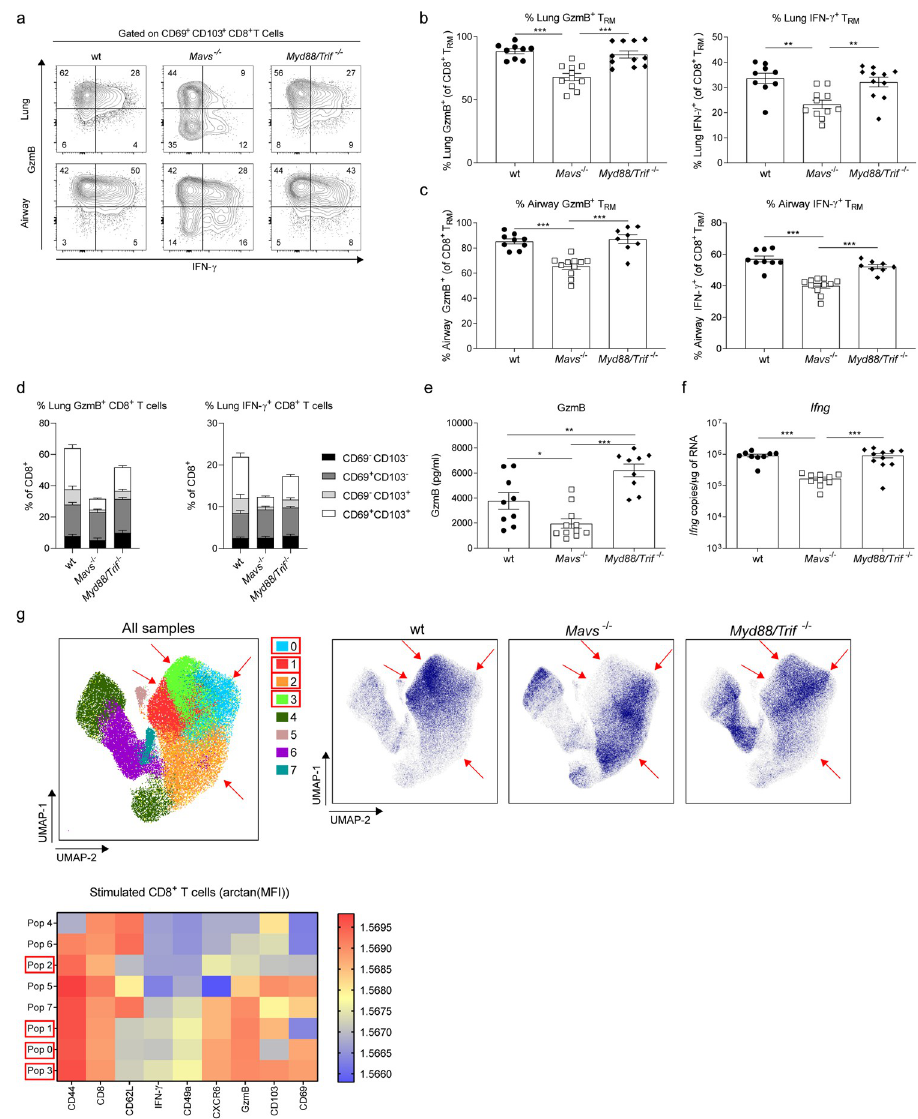
Fig 5. MAVS deficient mice show functionally impaired T RM cells during RSV re-infection. RSV re-infected wt, Mavs -/- and Myd88/Trif -/- mice were euthanized after four days and airway and lung cells stimulated with RSV M 187- + T cell intracellular production of GzmB and IFN- γ was determined by flow cytometry. ( a ) 195 peptide and CD8 Representative flow cytometry plots of GzmB and IFN- γ producing CD69 + CD103 + T RM cells. Percentage of GzmB + and IFN- γ + CD103 + CD69 + T RM cells were quantified as a percentage of total CD103 + CD69 + T RM cells in the ( b ) lungs and ( c ) airways. ( d ) Stacked analysis of percentage of GzmB + or IFN- γ + T EM cells subsets discriminated by CD69 and CD103 surface expression. ( e ) GzmB was quantified by ELISA in BAL fluid. ( f ) Ifng mRNA detected in lung tissue using RT-qPCR. ( g ) Lung cells were stimulated with RSV M 187-195 peptide and stained for flow cytometry analysis. Total CD8 + T cells were downsampled and concatenated and this file was submitted to unsupervised dimensionality reduction using UMAP software. Clusters were automatically identified using FlowSOM and density plots for concatenated (All samples) including identified populations for each genotype is shown. Heatmap with the marker expression of each of the 8 populations identified is also depicted. Populations that show mayor differences are pointed with red arrows and squares in the legend. Data are presented as the mean ± SEM of 9 re-infected wt, 11 re-infected Mavs -/- and 11 re-infected Myd88/Trif -/- mice pooled from two independent experiment. Statistical significance of differences between groups was determined by one-way ANOVA with Tukey’s post hoc test. � P � 0.05, �� P � 0.01, ��� P �